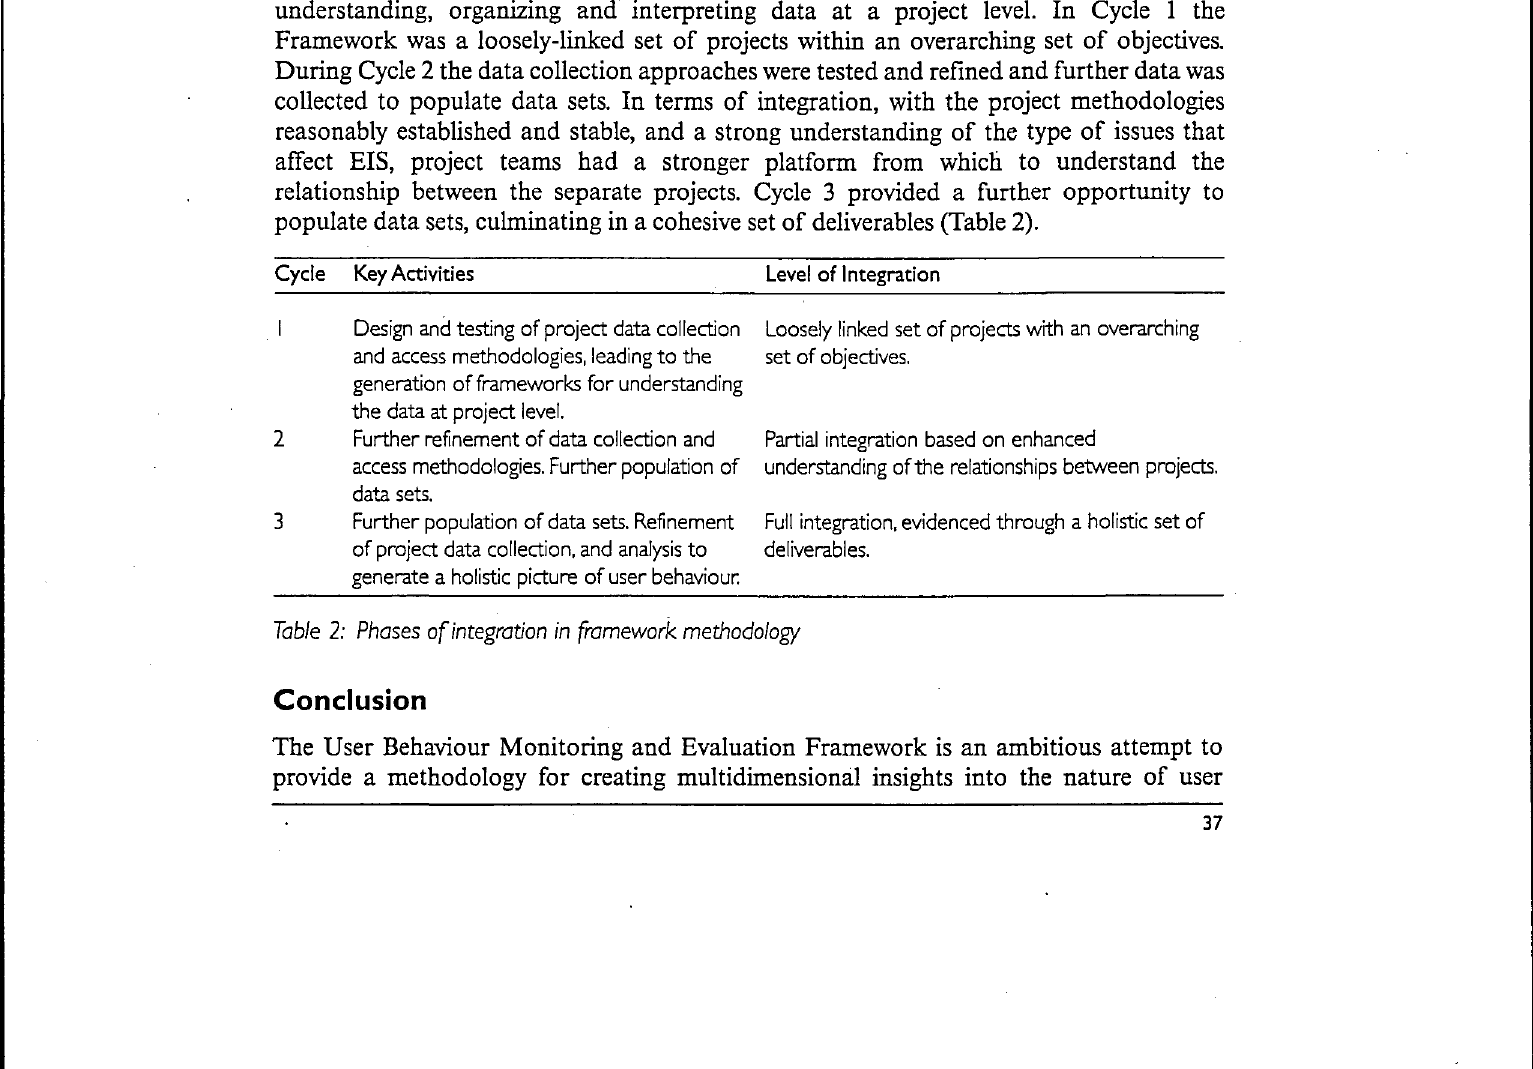
Table 2: Phases of integration in framework